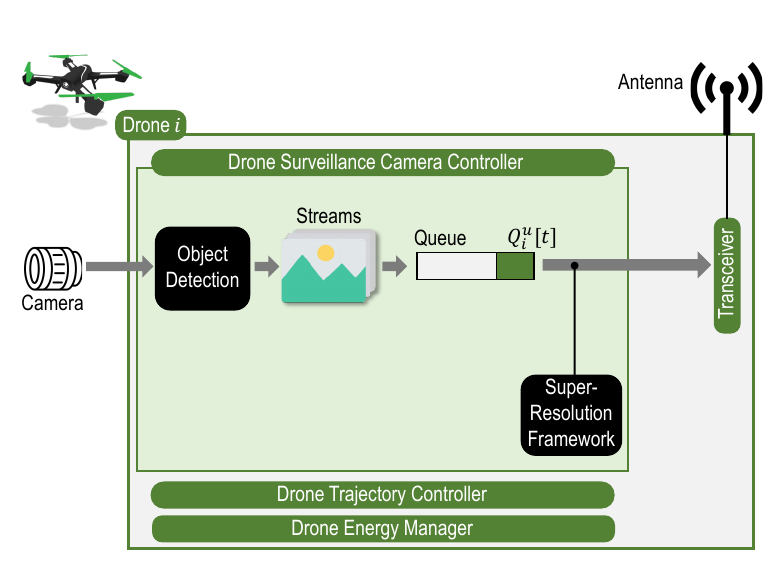
Figure 1. Reference System Model. Table 1. Processing time and resolution (peak-signal-to-noise ratio, PSNR) measurement results depending on the number of hidden layers (note that simulation settings are equivalent to the settings in VSDR